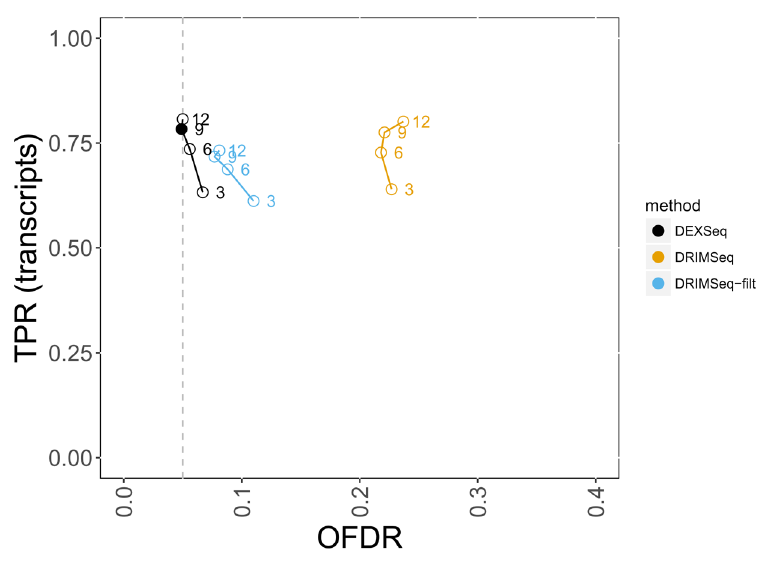
Figure 10. Number of true positives and observed overall false discovery rate (OFDR) using stageR for 5% target, on the “fixed per-gene dispersions” simulation.